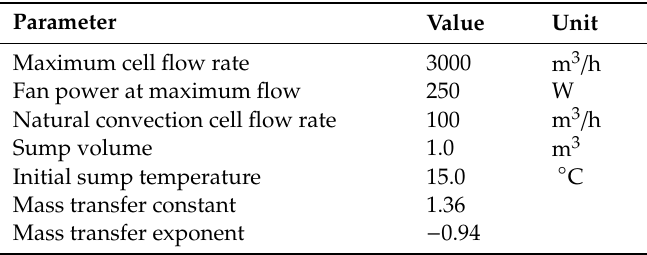
Table 7. Description of the cooling tower.